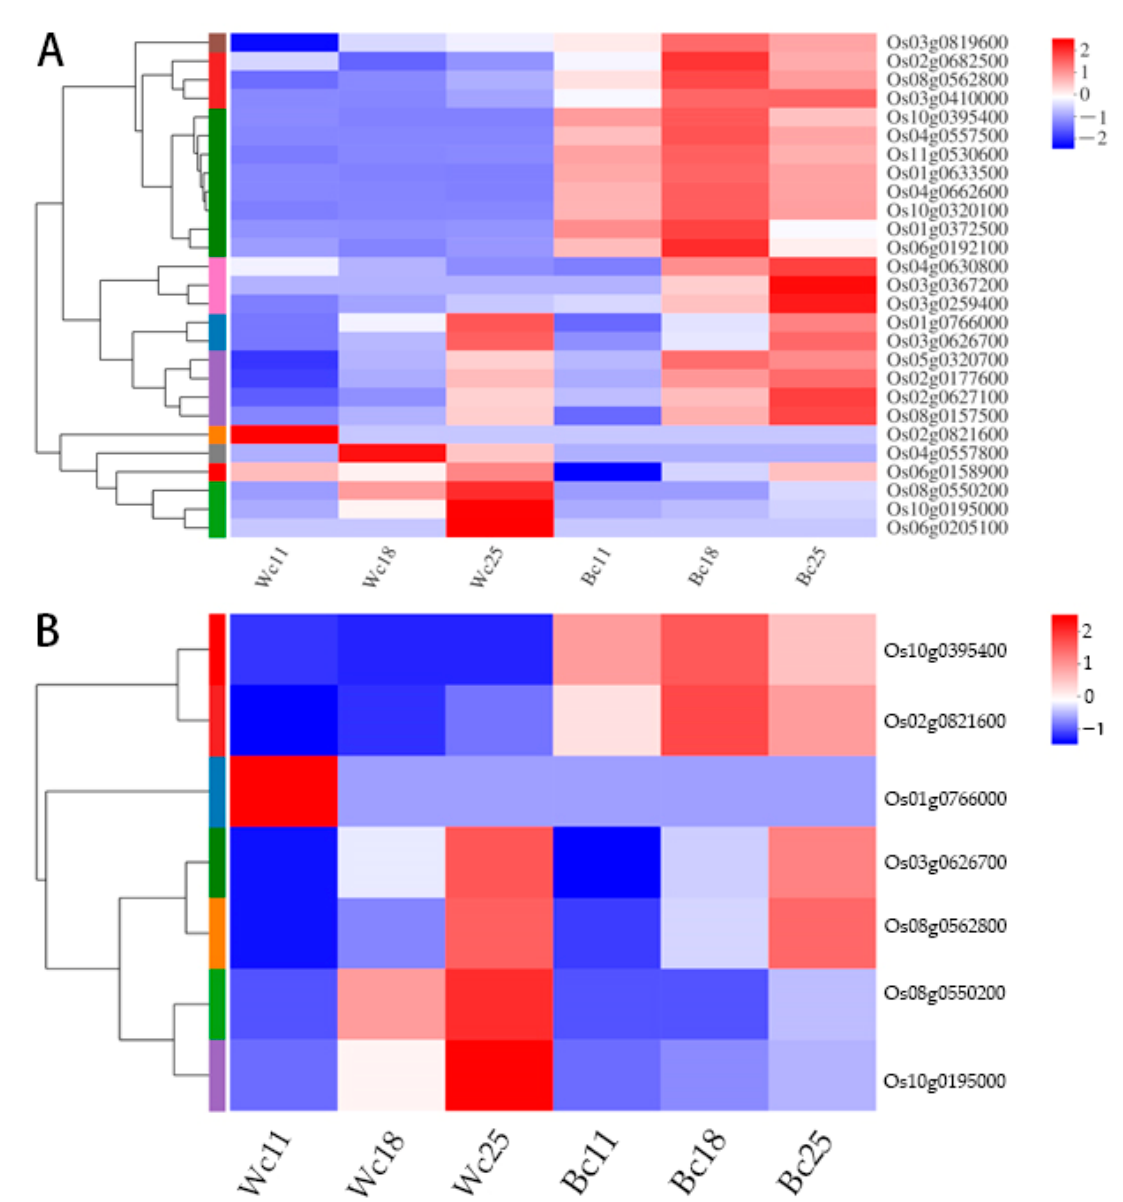
Figure 8. Heatmap showing expression profile and cluster analysis of DEGs in different samples: ( A ) Expression profile of twenty-seven anthocyanin biosynthesis DEGs including putative transporters. ( B ) Heatmap representation and hierarchical clustering of the transporters genes of various samples in black and white caryopsis. The transcript data of six samples from rice caryopsis were used to reconstruct the expression patterns of genes. The clear boxes indicate that the transcript abundance is zero. The bar at the right side of the heat map represents the relative expression values; values below 0 represent downregulated expression and values above 0 represent upregulated expression.